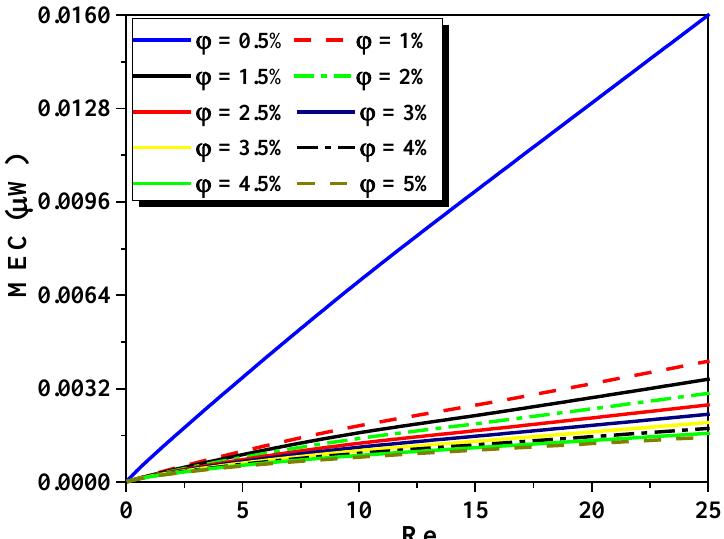
Figure 15. Development of Mixing Energy Cost for several generalized Reynolds numbers (Re g = 0.1 to 25) for various nanofluid concentrations ( ϕ = 0.5 to 5%).